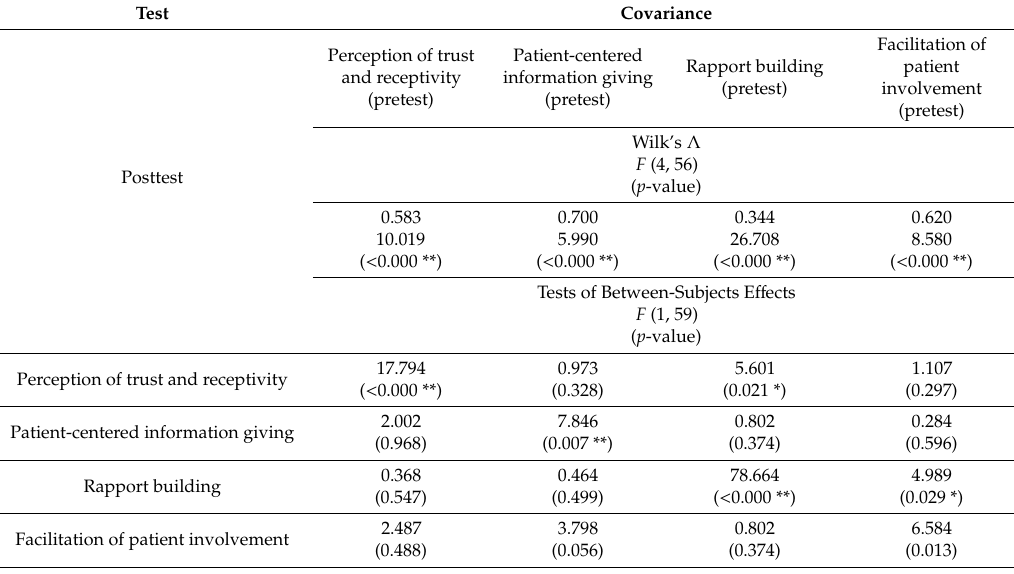
Table 5. MANCOVA results for the Patient–Healthcare Provider Communication Scale (P-HCS)